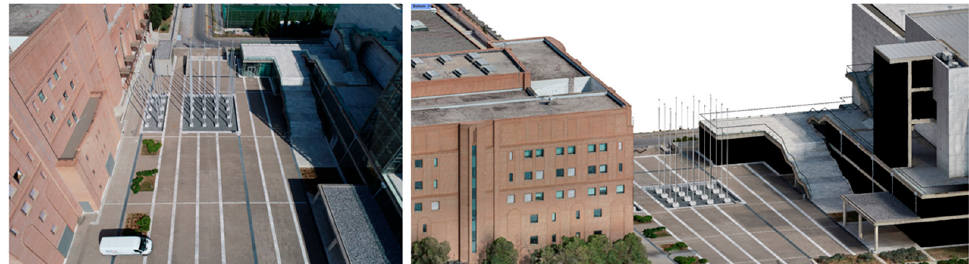
Figure 5. On the ( left ) we have a real image of a specific place, while on the ( right ) we have a screenshot from the corresponding 3D model that depicts a similar view as the real image with similar visual features. The image sentiment analysis algorithm produces a “neutral” result for valence for both images.